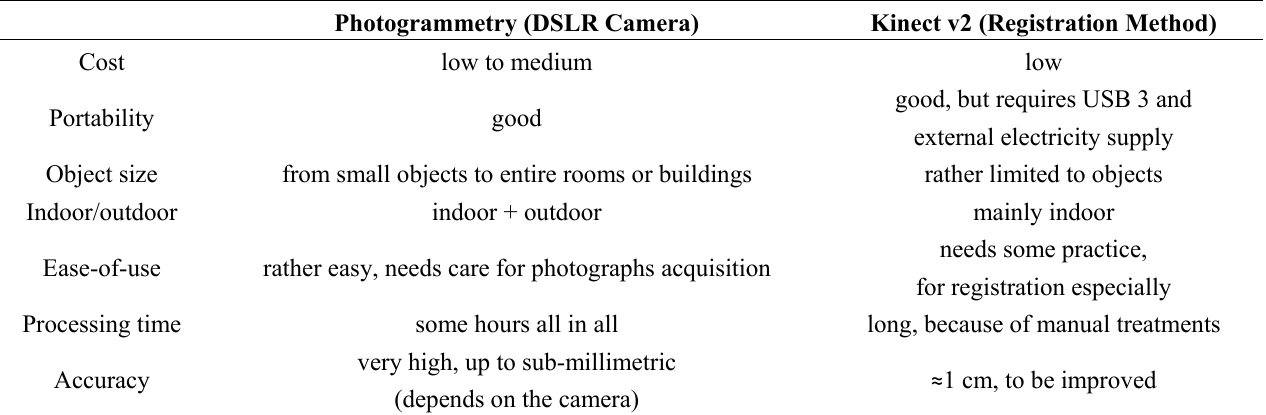
Table 2. Comparative overview of some criteria for the image-based and for the Kinect-based 3D reconstruction